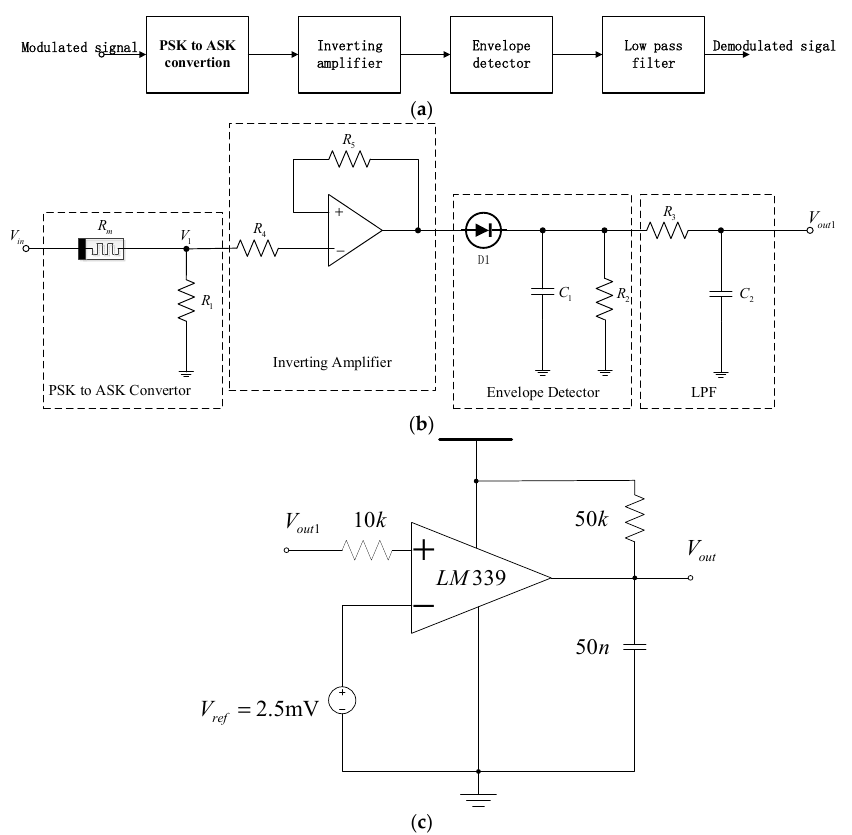
stead of the ideal model in [13].